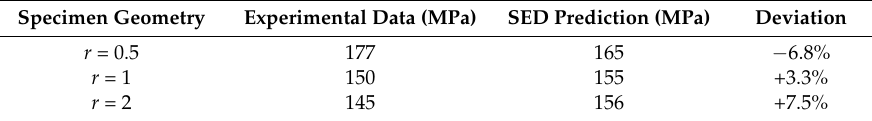
Table 4. Prediction of tensile failure of axisymmetric specimens machined with notched radii of 0.5, 1 and 2 mm using the SED approach.